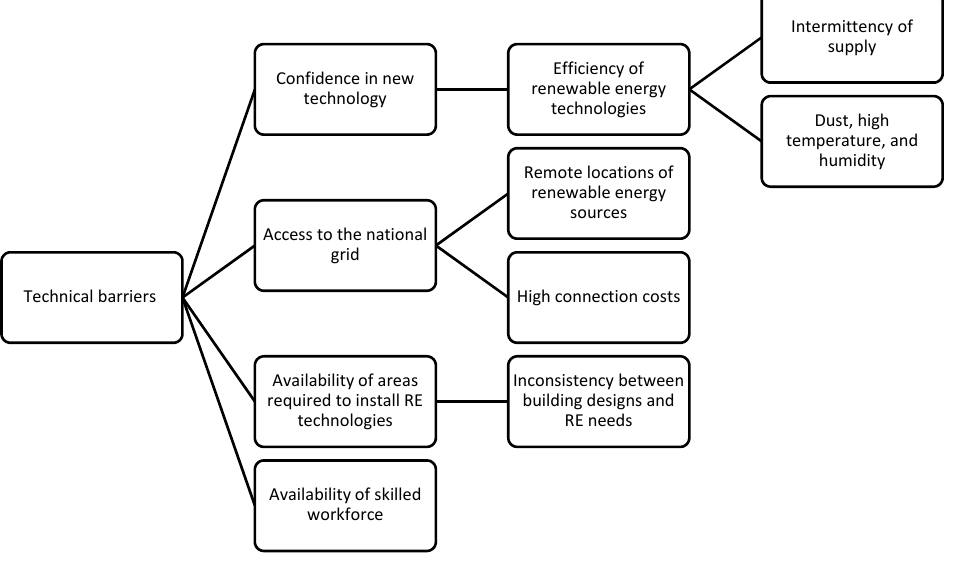
Figure 4. Technical barriers for renewable energy adoption in the GCC. Adapted from [48].